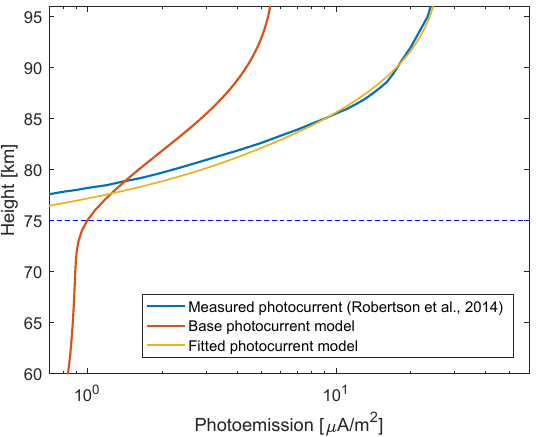
Figure 12. Residual between the photocurrent measurements from Robertson et al. (2014) and the fitted photocurrent model.